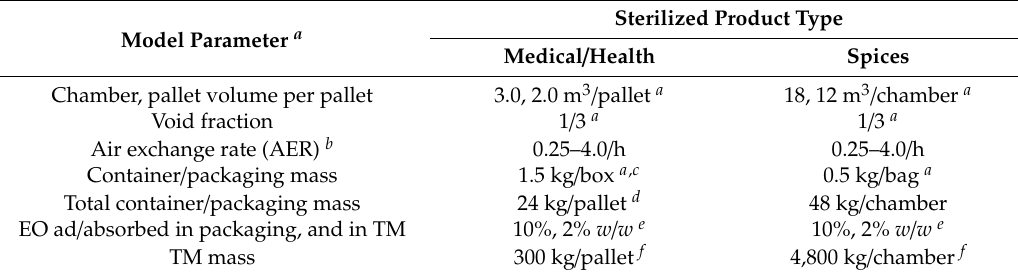
Figure 2. Engineering / industrial-hygiene (E / IH) model of occupational respiratory exposure to EO used to sterilize ( A ) medical / health products during the Late Period and ( B ) medical / health products during the Early and Middle periods, and spices during the Late Period. Table 2. Scenario assumptions applied for all modeled periods.